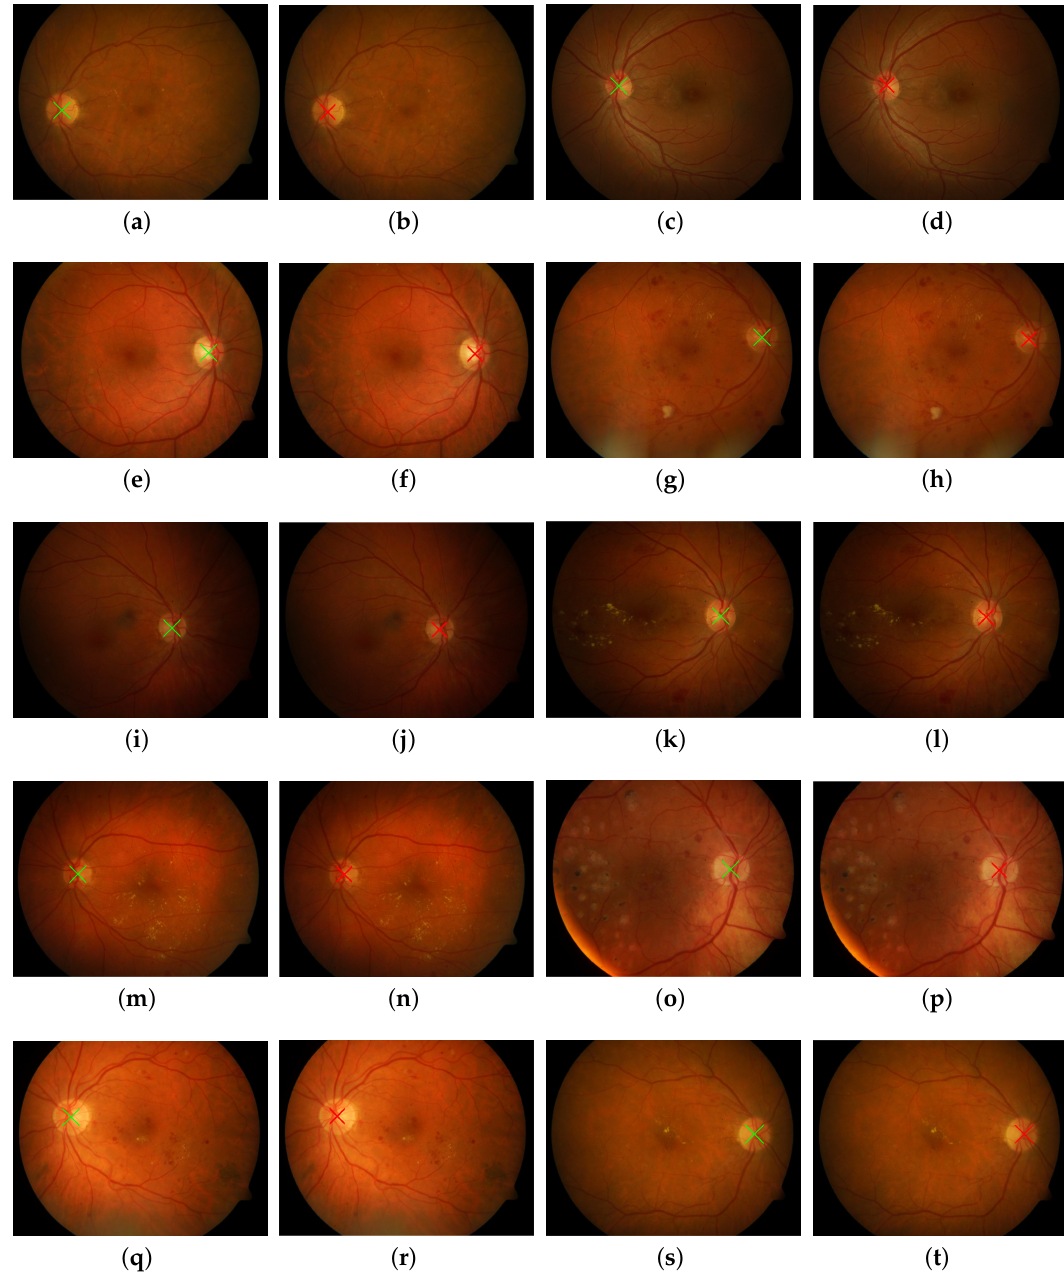
Figure 4. Results of the proposed method (the red cross represents the estimated OD center). ( a , c , e , g , i , k , m , o , q , s ) The OD center annotation ground truth. ( b , d , f , h , j , l , n , p , r , t ) Results of the proposed method on the DIARETDB1